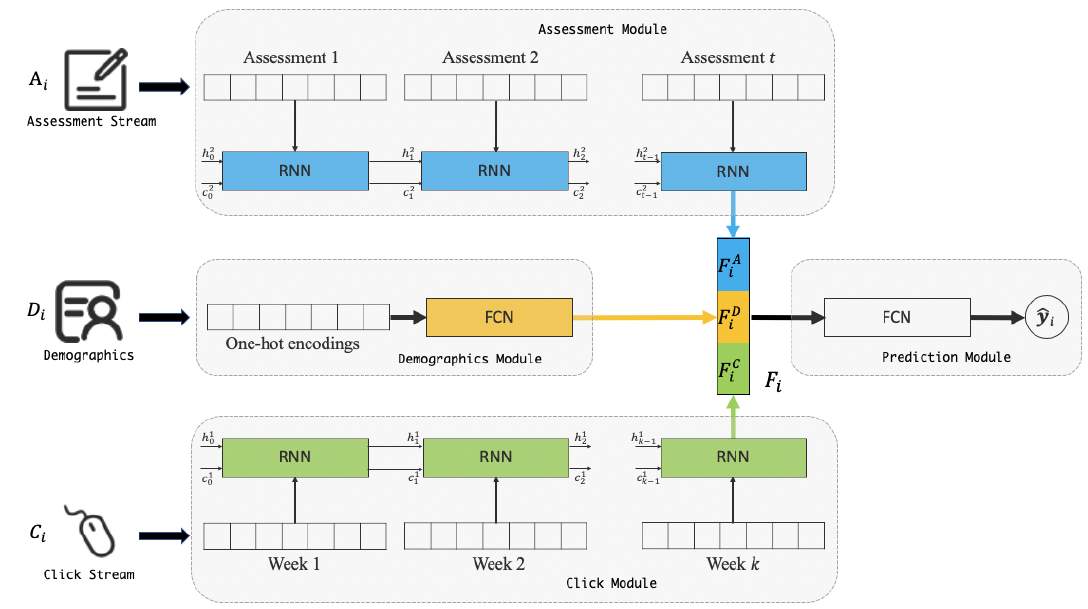
Figure 2. Overview of the proposed